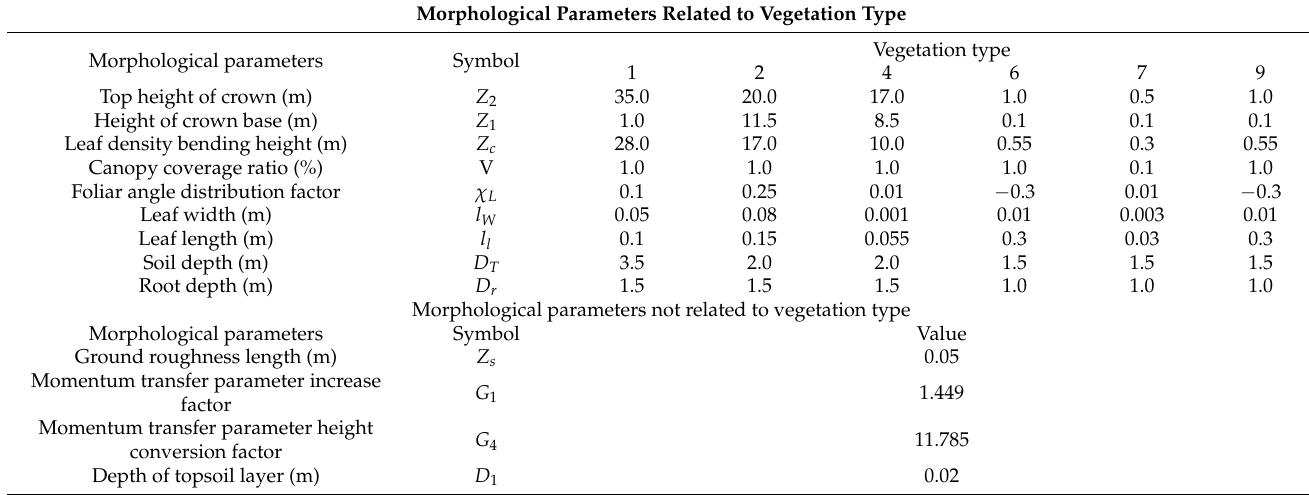
Table A3. Vegetation morphological parameters.